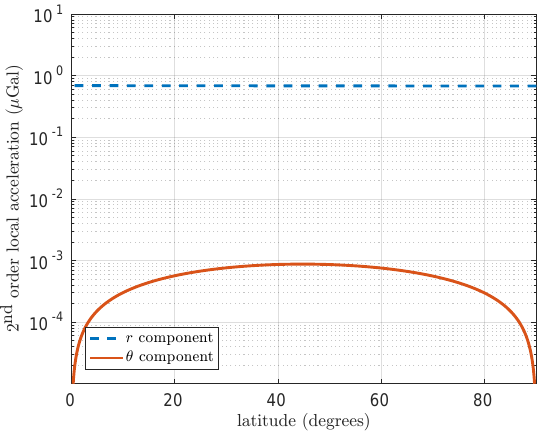
Figure 1. Second order ( c − 2 ) contributions to the local acceleration γ